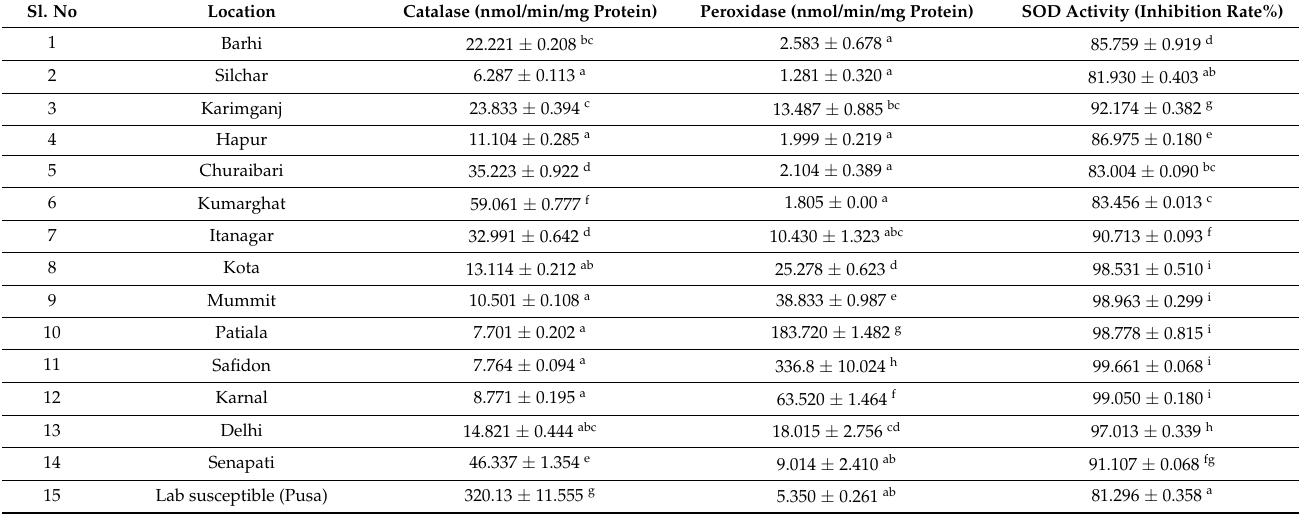
Table 3. Antioxidant enzyme activities in field populations of Rhyzopertha dominica